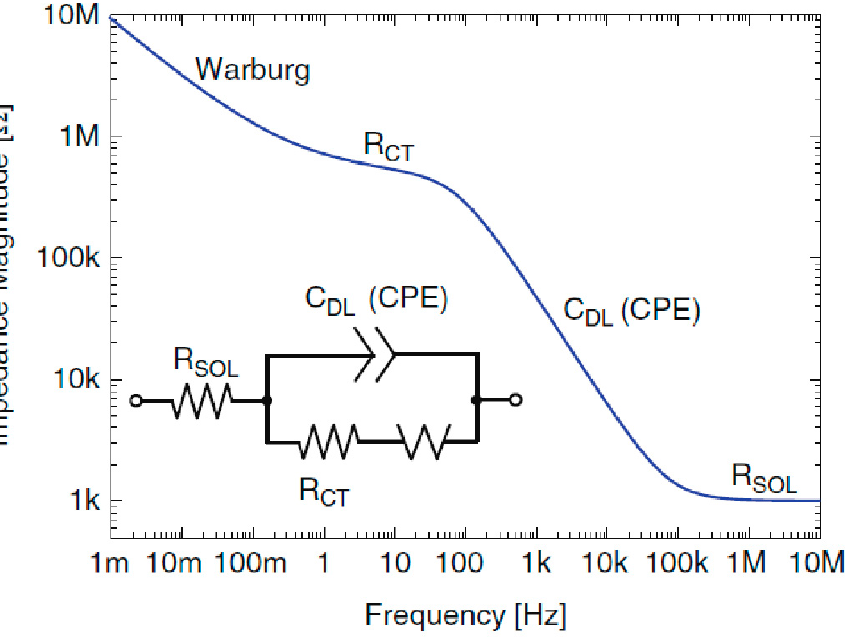
Figure 3. Bode plot of the impedance magnitude of the Randles equivalent model of an electro- chemical interface comprising both non-Faradaic and Faradic phenomena [9]. cal interface comprising both non-Faradaic and Faradic phenomena